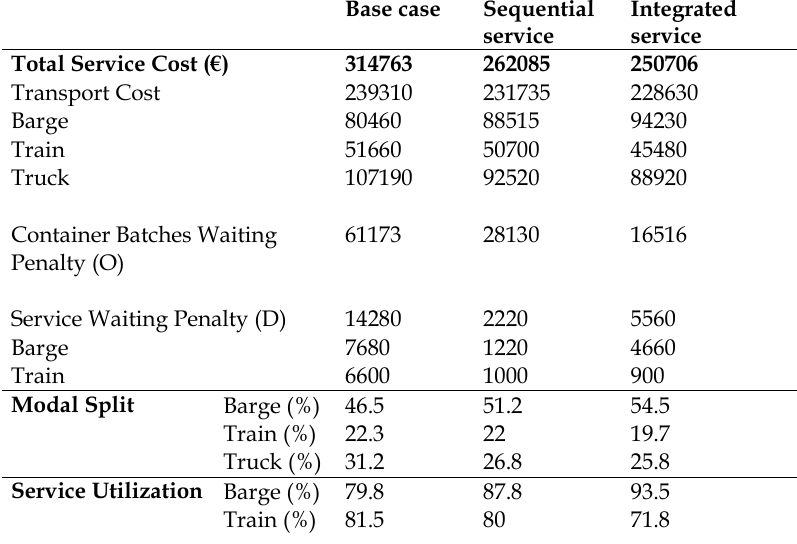
Table 3. Results for three